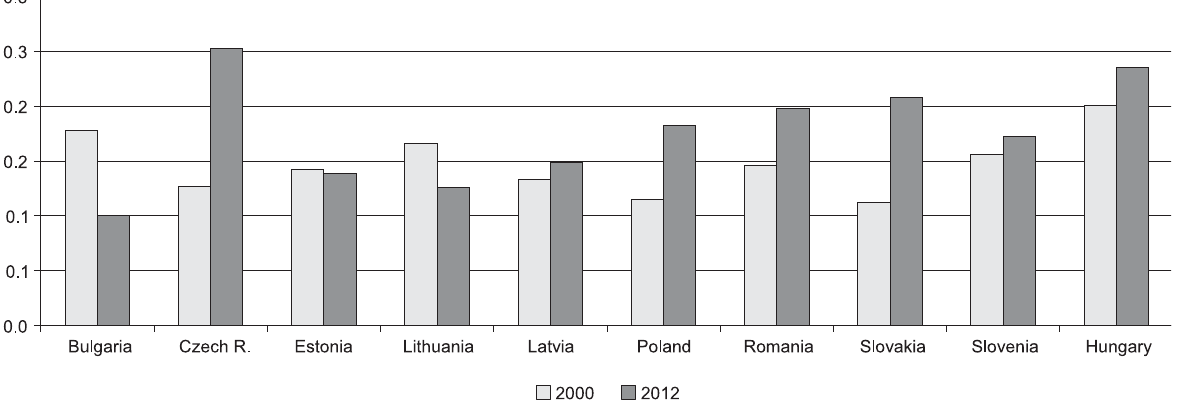
Fig. 6. Indicators of similarity between the commodity import structures of the post-communist countries and the EU-15, 2000 and